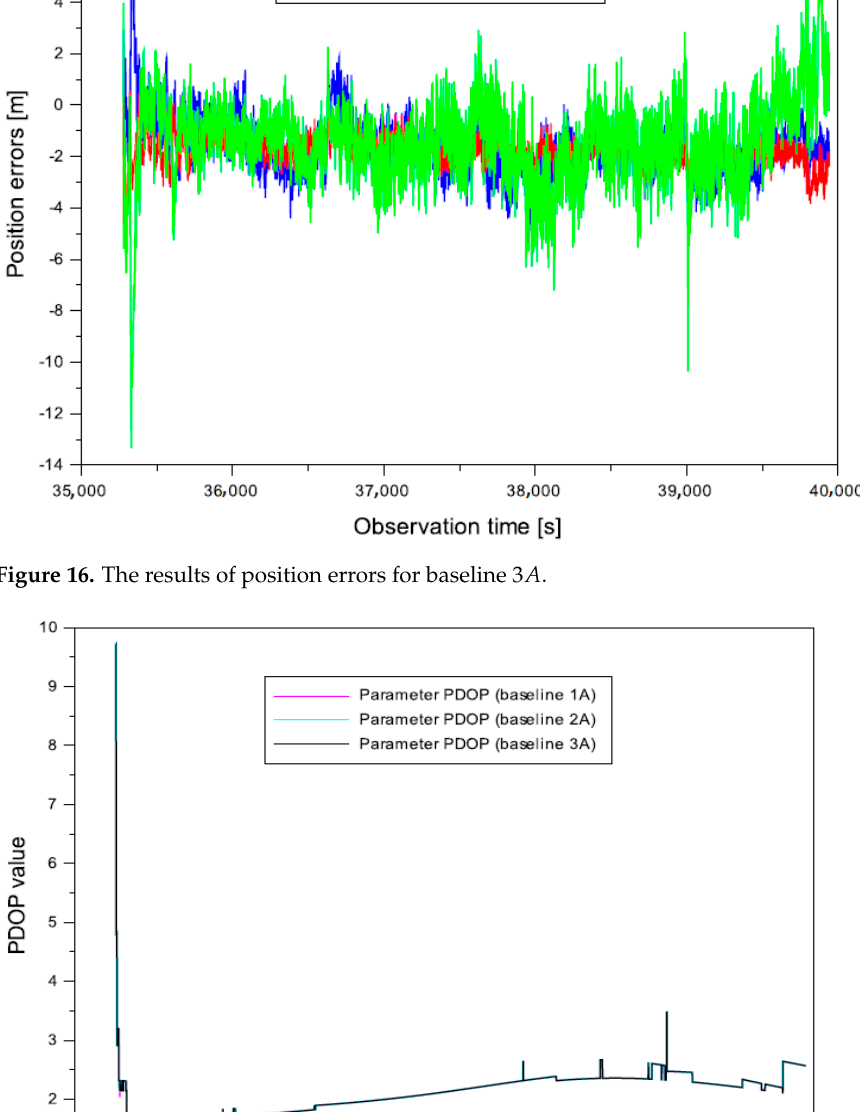
Table 4. The results of parameters ( , , ) rdB rdL rdh in flight test in D ę blin.